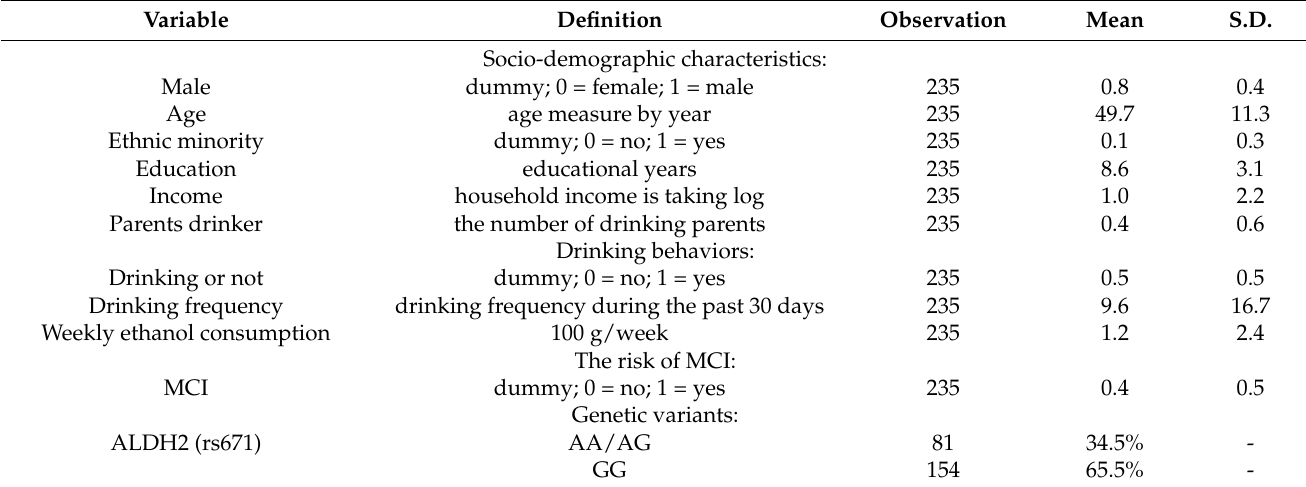
Table 1. Basic characteristics of genetic sample.